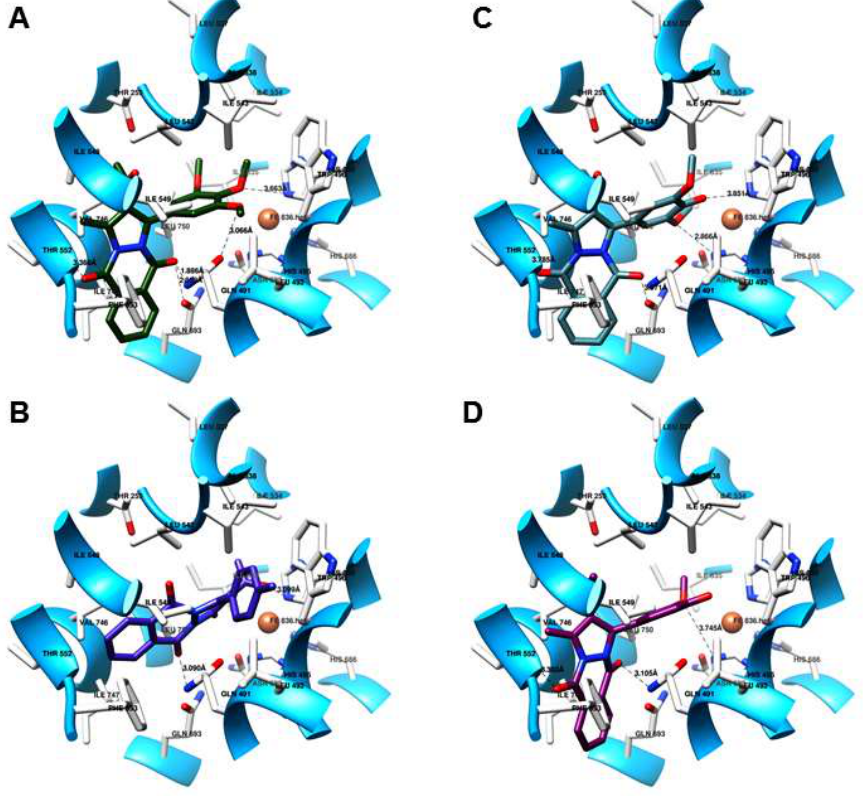
Figure 4. The bioactive conformation of PPD-10 (A); PPD-2 (B); PPD-9 (C); PPD-8 (D). The LOX-Ib amino acids are presented in white, the LOX-Ib ribbon is colored in blue. For the clarity purpose, only polar hydrogen atoms are